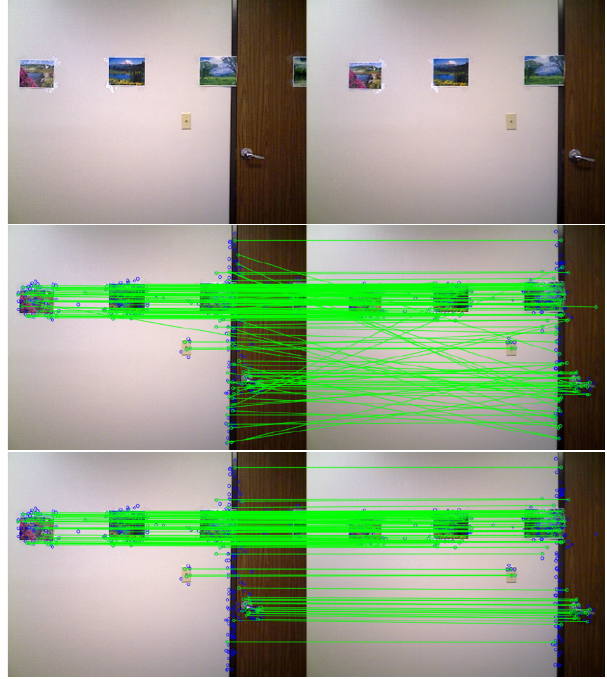
Fig. 3 Two original images (top), feature matching before (middle) and after (bottom) correspondence checking. domain. The FCL is composed of 3D point sets, each of which denotes a series of 3D points in the camera’s local coordinate space, whose corresponding 2D pixels are matched features across